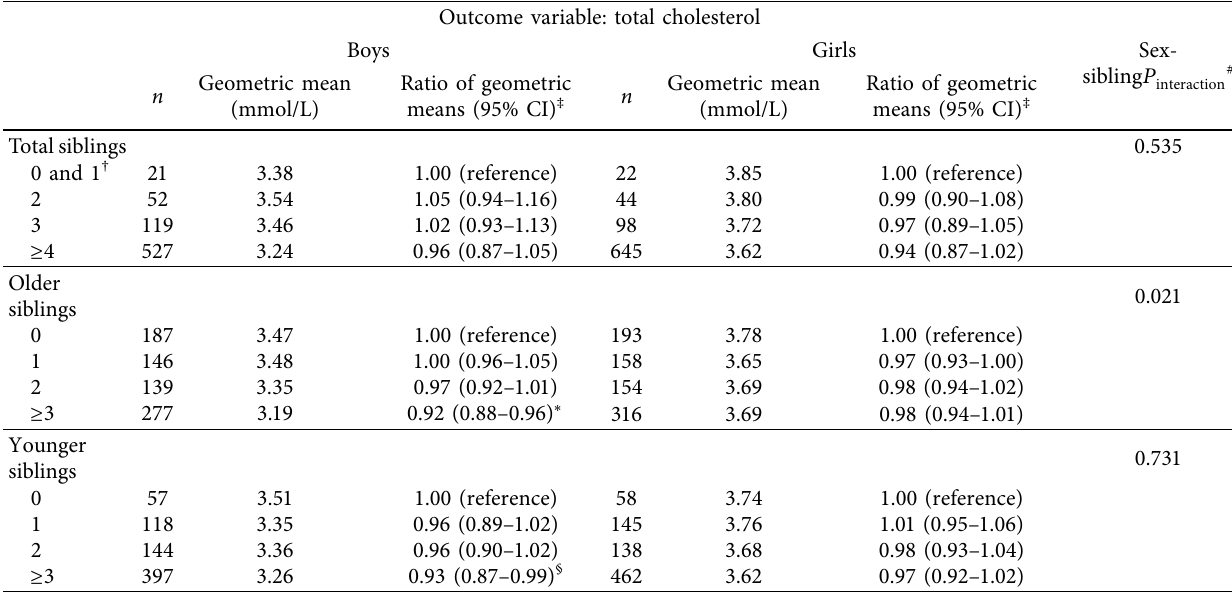
Table 2: Geometric means and adjusted ratio of geometric means of total cholesterol according to the total number of siblings, number of older siblings, and number of younger siblings stratified by sex.